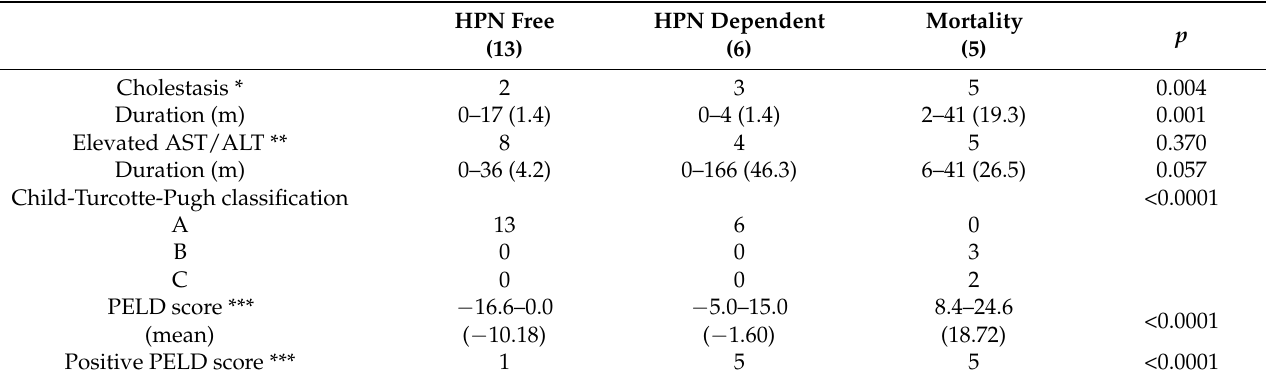
Table 5. Liver function and cholestasis of HPN